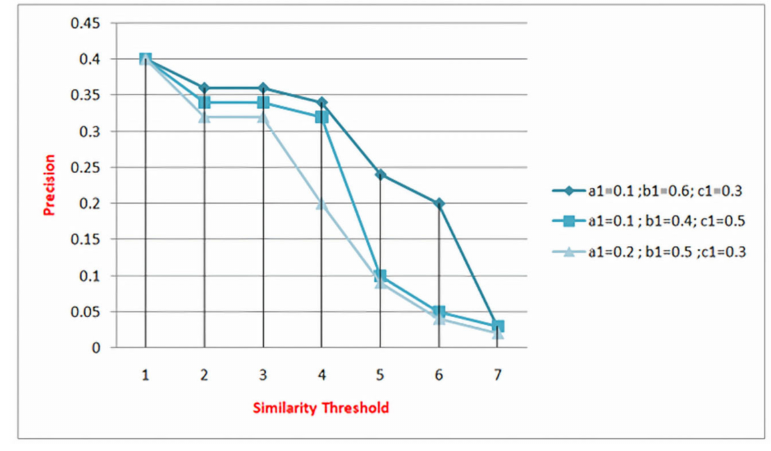
Figure 7. Social parameter weight identification.